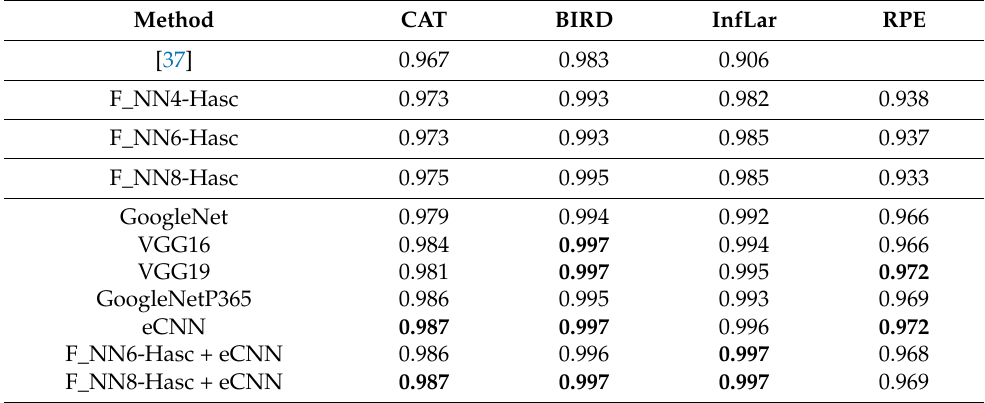
Table 5. Performance (AUC) obtained considering different standard CNNs. Best values are in bold-faced.